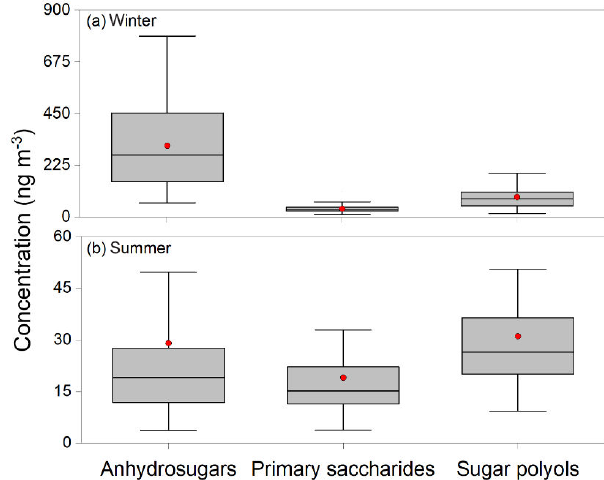
Figure 9. Concentrations of sugars including anhydrosugars, pri- mary saccharides, and sugar polyols in Tianjin aerosols. Boxes with error bars represent the 25th and 75th percentiles for each season. The solid lines and the red dots in the boxes represent the median values and average values respectively.